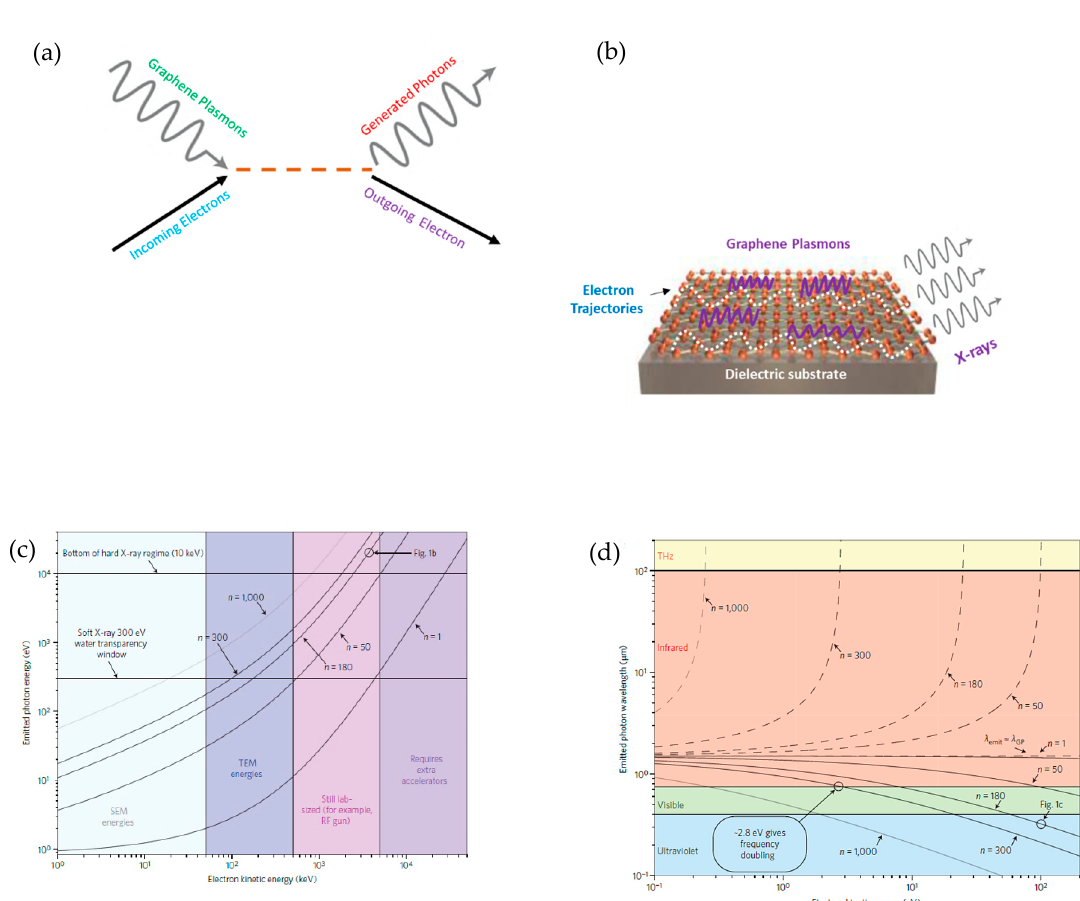
Figure 7. Graphene plasmonic-based source for short wavelength radiation. ( a ) shows the electrons-plasmon interaction, where the white dotted line demonstrates the free electrons interacting with plasmons glowing with blue and red bars, ( b ) illustrates the process of graphene plasmons emission from hot carriers. ( c ) The soft and hard X-ray radiation from graphene-based free electrons radiation source was achieved without any acceleration stage, with various frequency conversion region, the lines correspond to confinement factor ( n = 1,50 ... 1,000) where n = 1 is shown as a reference. ( d ) shows the up-converting (black line) and down convection (dash line) of related frequency from graphene-based free electrons source. It is observed that the coupling of phase velocity of graphene plasmons velocity and electrons velocity cause the down-conversion of frequency [116].